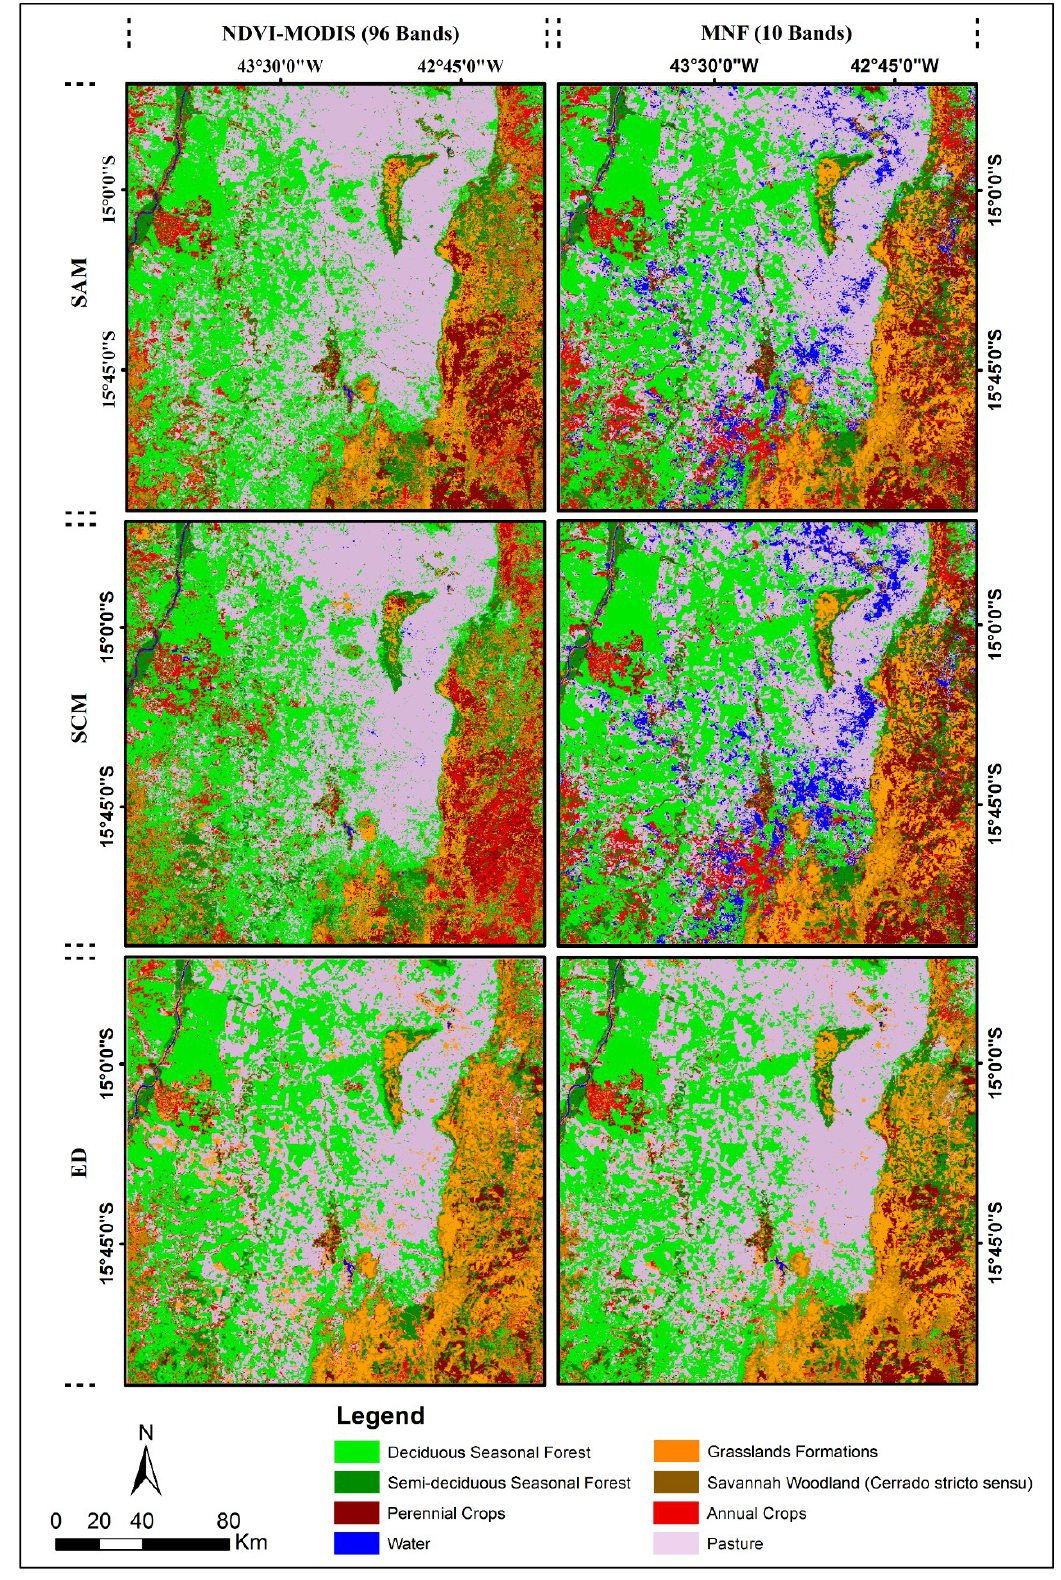
Figure 8. Classified images considering two types of input data (NDVI-MODIS time series and MNF signal components), three types of similarity and distance measures (SAM, SCM, and ED), and the more specific set of use classes (eight